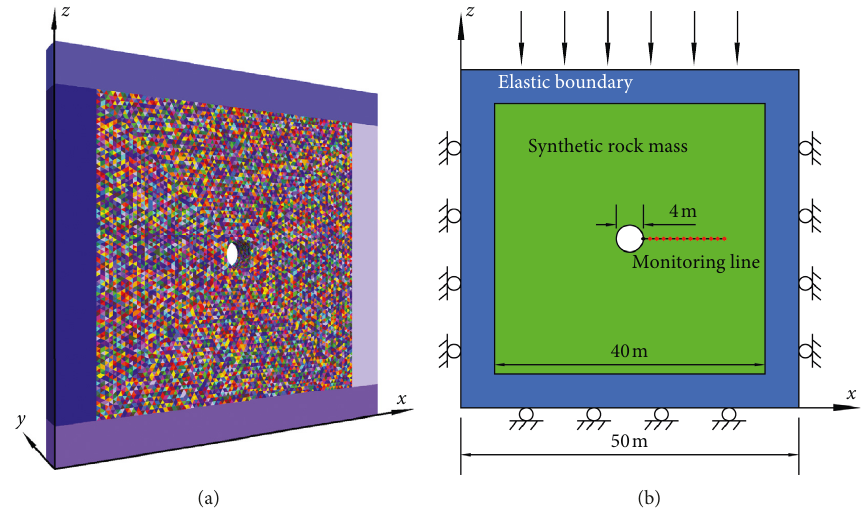
Figure 7: Numerical model for zonal disintegration test: (a) cuboid model created in 3DEC; (b) sketch of the numerical model.